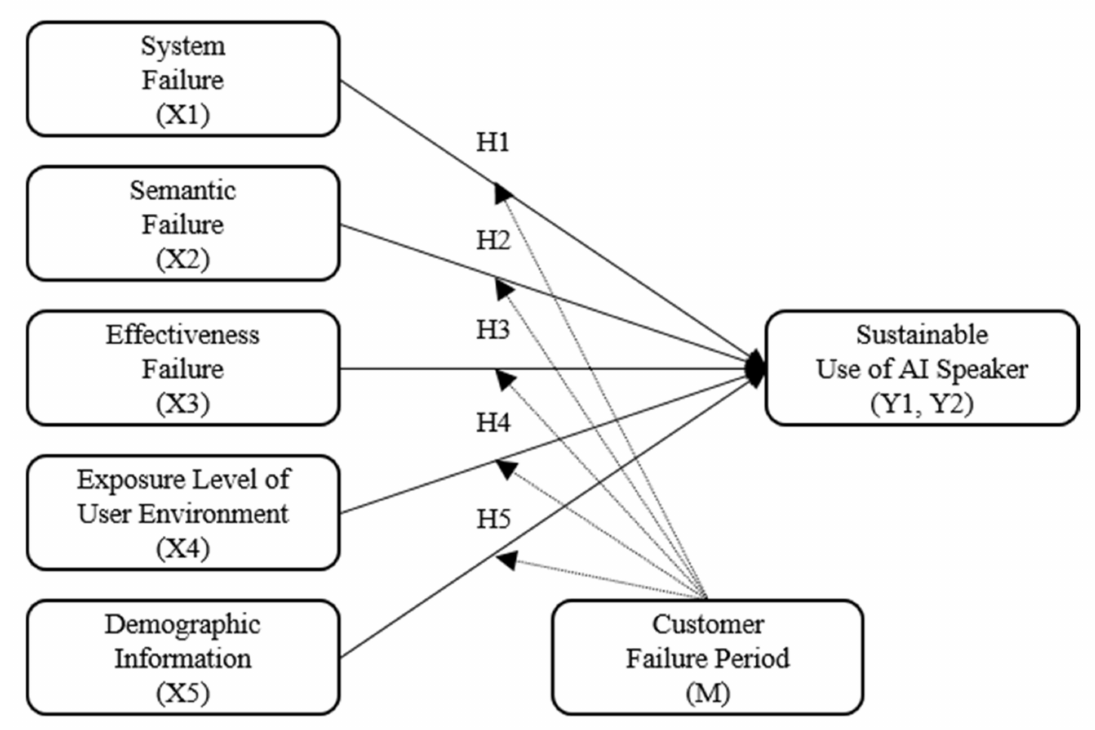
Figure 6. Causality of the